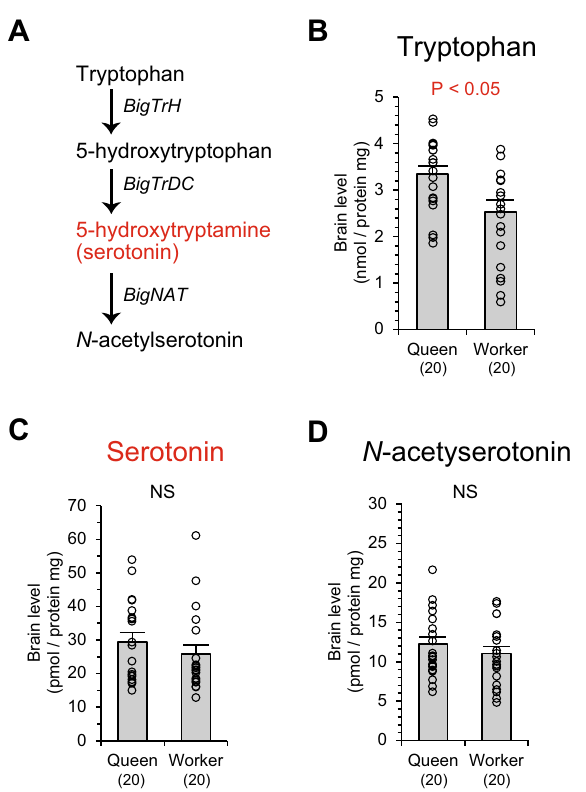
Figure 3. Levels of serotonin and its related substances in the brain of queens and workers in Bombus ignitus . A metabolic pathway of serotonin is indicated ( A ). Serotonin is synthesized from tryptophan via 5-hydroxytryptophan and converted into N -acetylserotonin. Enzyme genes mediating the biosynthetic reaction are indicated in italics. Serotonin is a functional monoamine (red). Amounts of tryptophan ( B ), serotonin ( C ), and N -acetylserotonin ( D ) in the brains of queens and workers are indicated. Numbers in parentheses indicate the number of samples examined. Data were obtained from 10 individuals in each caste per colony (two colonies). Individual data of biogenic amine levels were indicated by plots in graphs and in Table